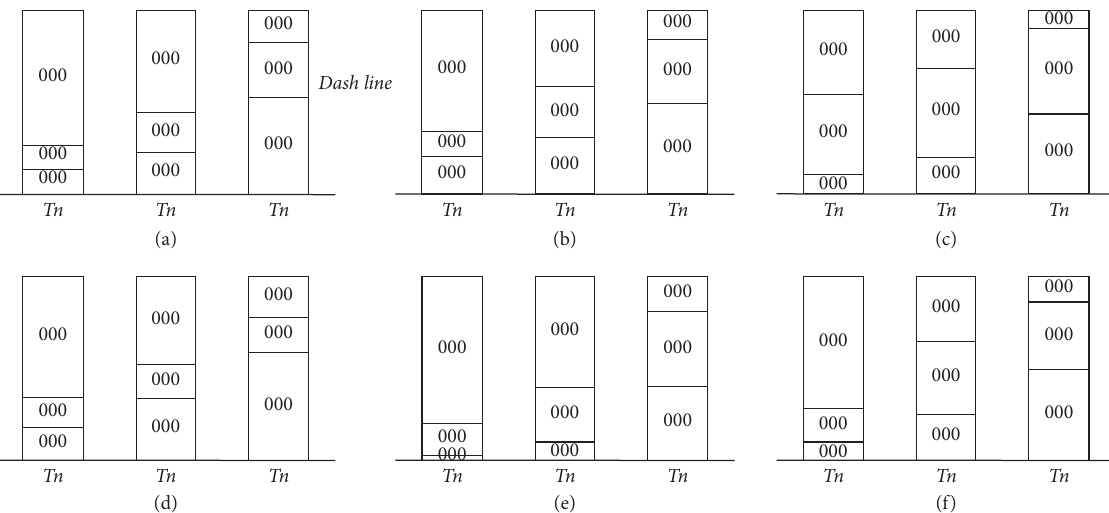
Figure 8: The curves of the search window and occlusion factor. (a) Series 1. (b) Series 2. (c) Series 3. (d) Series 4. (e) Series 5. (f) Series 6.